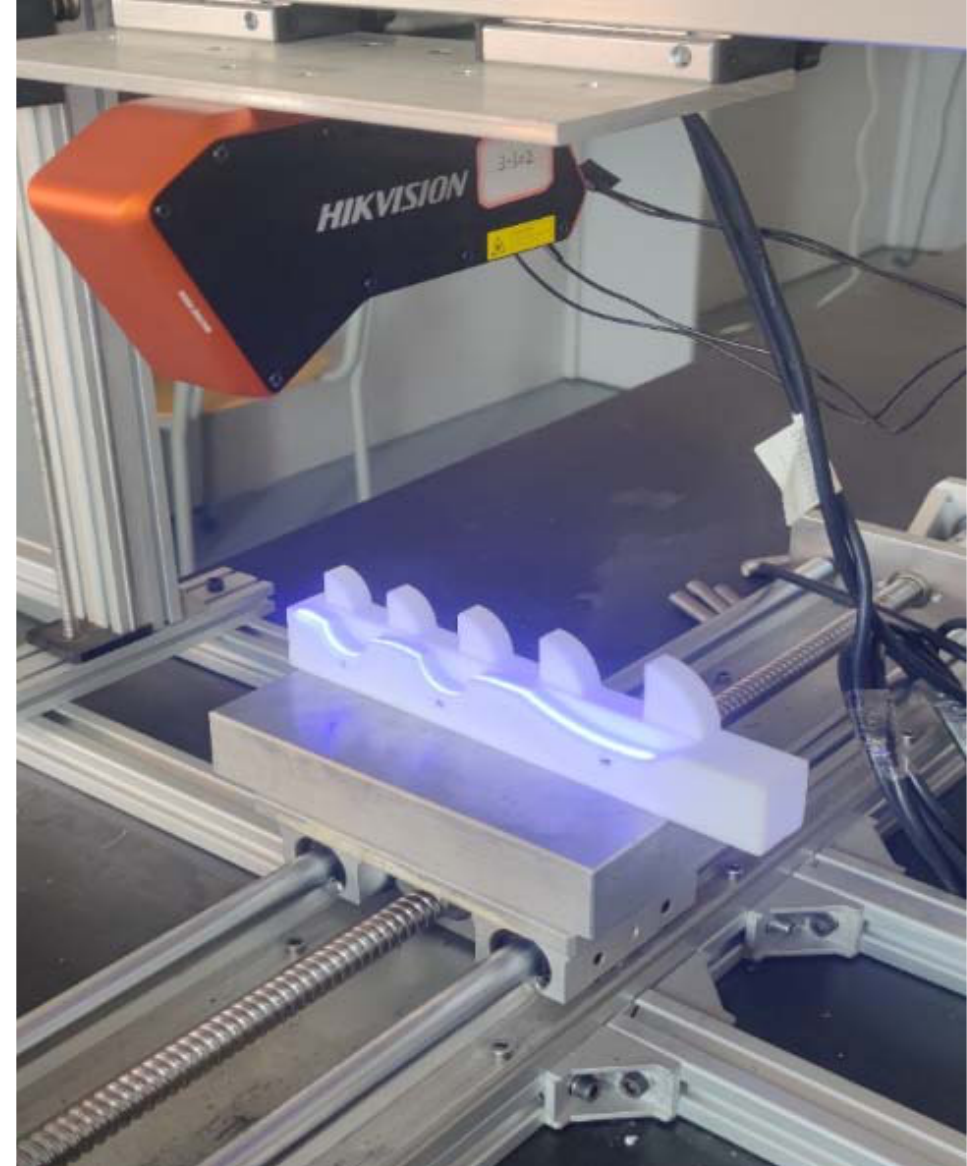
Figure 11. The pre-experiment of selecting suitable neighborhood domain values. According to the results of the pre-experiment, and combined with the segmented points, the results of the discrete derivative experiment are shown in Figure 12; each segment arc’s radii of curvature values are shown in Tables 4–6. The Huang method [31] and the Yang method [32] were selected for comparison. In the figures and tables, the discrete derivatives are written as DD; the different methods’ relative errors are plotted in Figure